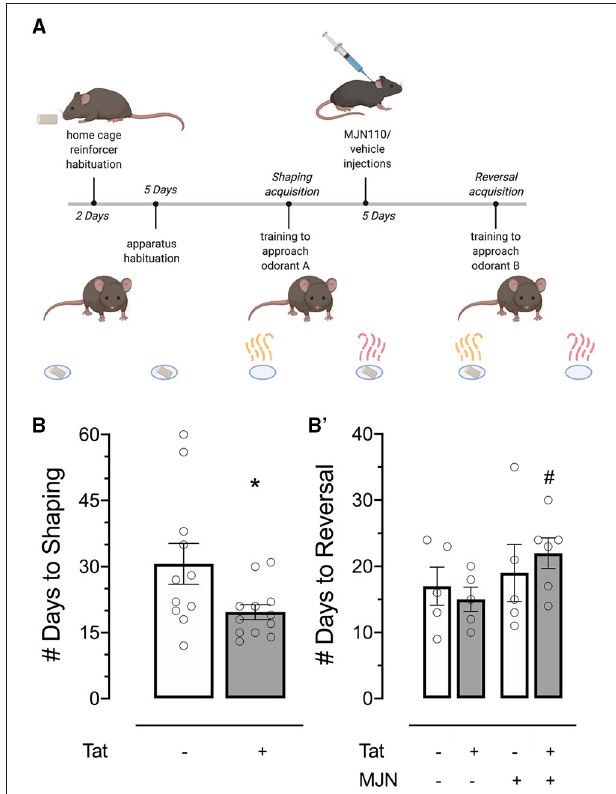
FIGURE 3 | (A) Behavioral timeline schematic for the two-choice Odor Discrimination Flexibility (ODF) task. (B) Tat( + ) subjects acquired the shaping task significantly faster than Tat(–) controls. (B’) MJN110-treated Tat( + ) subjects acquired the reversal task significantly slower than vehicle-treated Tat( + ) subjects. Data are mean ± SEM. Statistical significance was determined using ANOVA and Bonferroni correction where applicable. An alpha level of p < 0.05 was considered significant for all statistical tests. * p < 0.05 vs. Tat(–); # p < 0.05 vs. Tat( + )/vehicle.